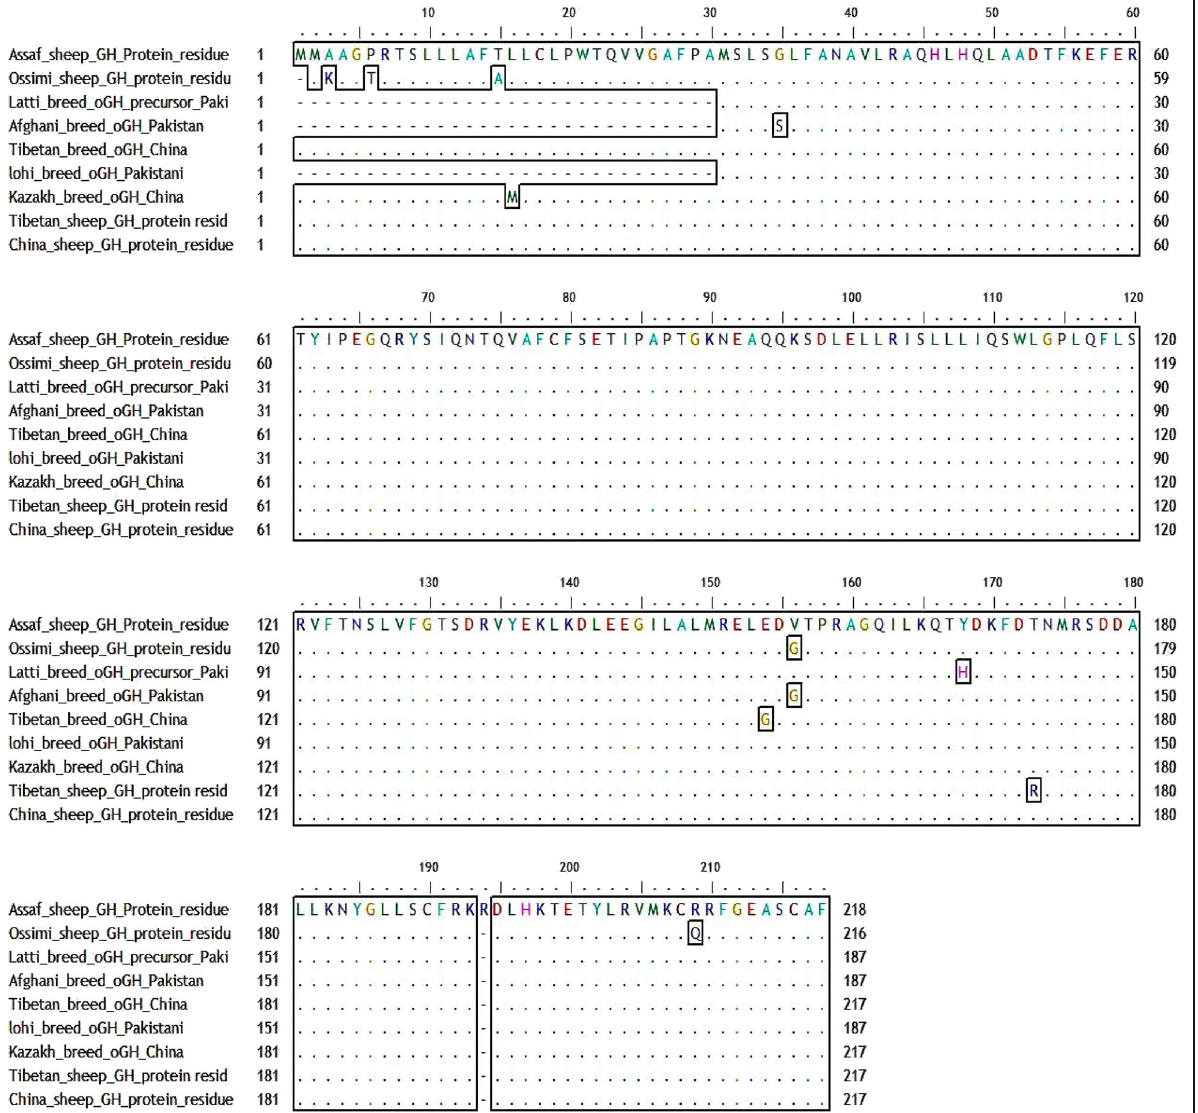
Fig. 19 Multiple alignment of As_GH protein sequence vs. GH protein sequence at GenBank sheep